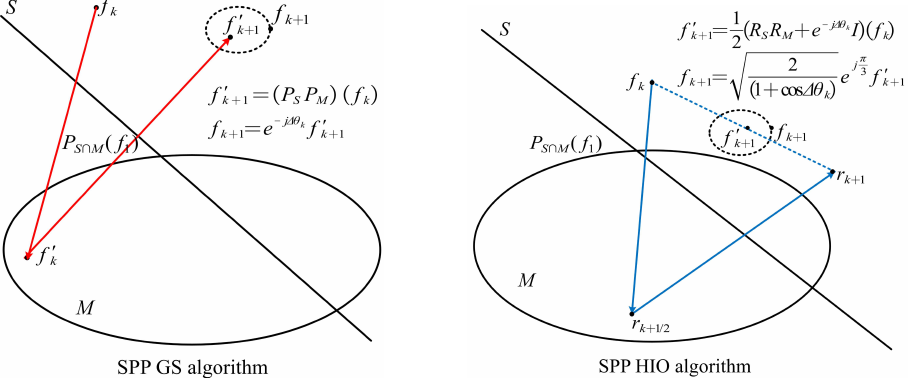
Figure 5. Schematic diagram of signal projection and update under the constraints of the SPP GS algorithm and the SPP HIO